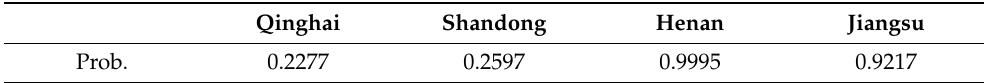
Table 6. Stationarity trait test results for TC.